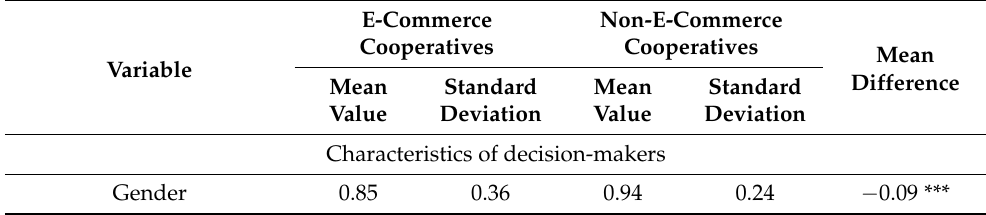
Table 3. Statistical description of the differences between variable